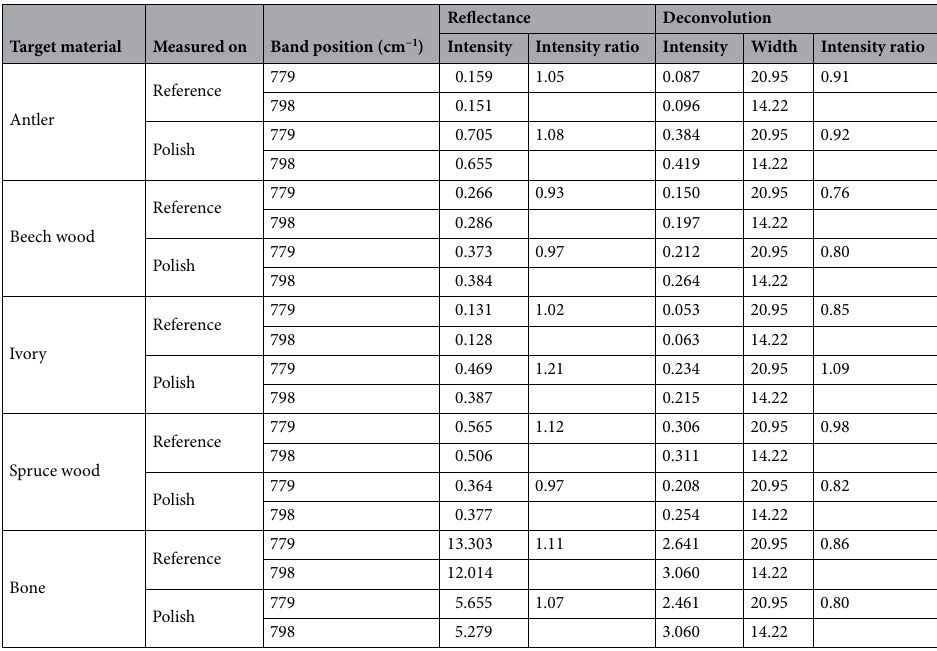
Table 1. IR Reflectance values and band components obtained by spectral deconvolution. Values under “reflectance” are the absolute reflectance values at both wavenumbers. Values under “Deconvolution” were obtained by fitting the reflectance spectra.